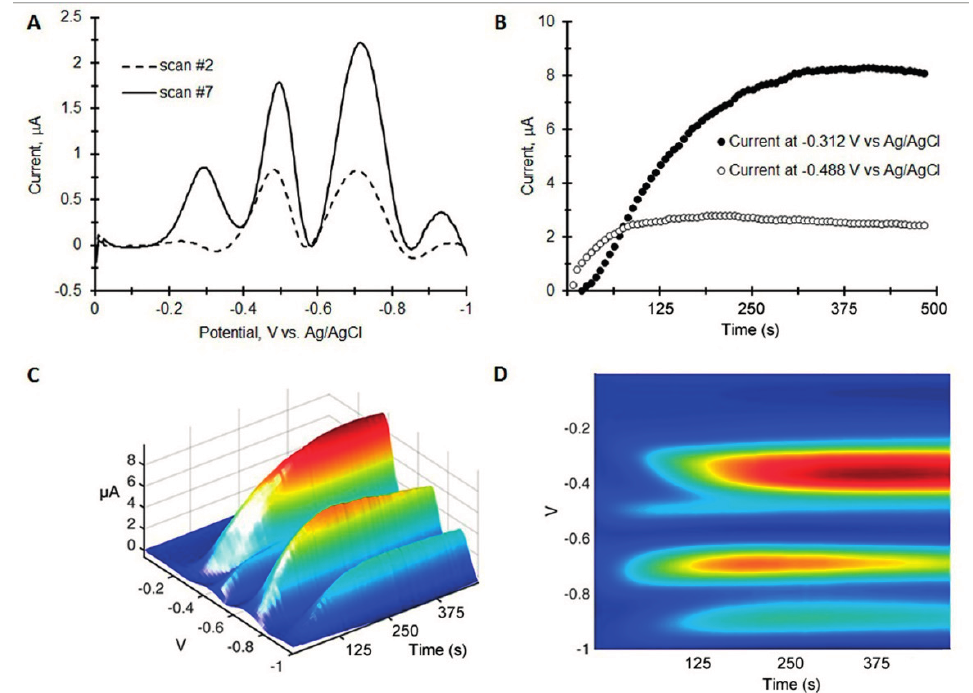
Figure 4. Separation of 5 µg of 4-Am-DNT and TNT placed on the paper-based electrochemical microelectrode ( A ) Square wave voltammograms at different time points; ( B ) Time traces at two different potentials; ( C , D ) 3D square wave chromatovoltammograms. Parameters: Amplitude = 25 mV, Frequency = 60